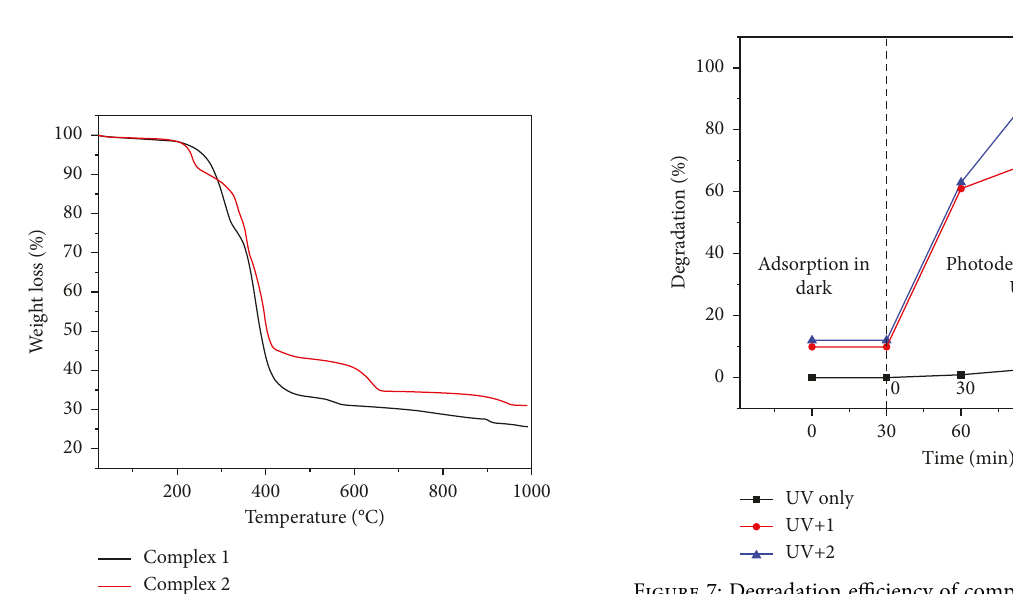
Figure 6: Thermogravimetric curves of complex 1 and complex 2.